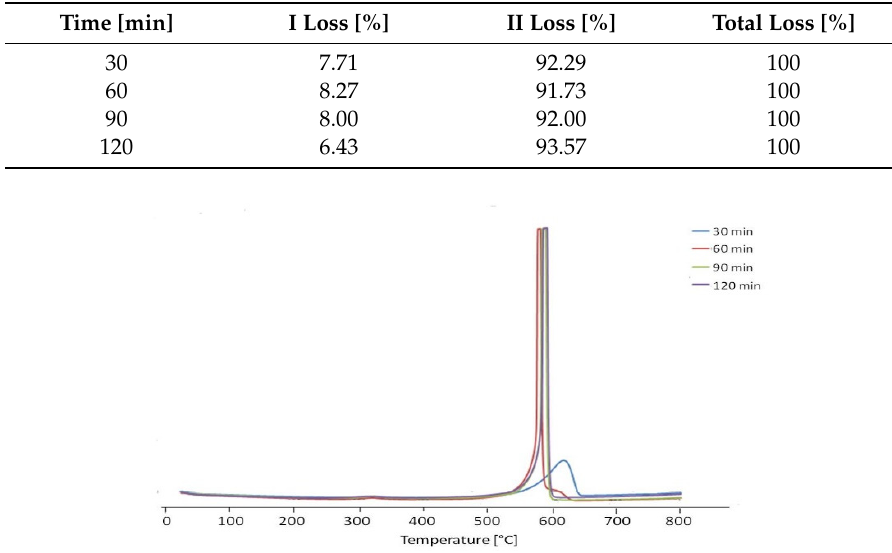
Figure 14. DTA curves of purified MWCNTs after adsorption of 10 mL of solution of 37 mg / L of Reactive Black 5 at di ff erent treatment times. Table 5. Exothermic DTA peaks of purified MWCNTs after adsorption of solution of 37 mg / L of Reactive Black 5 at di ff erent treatment times.